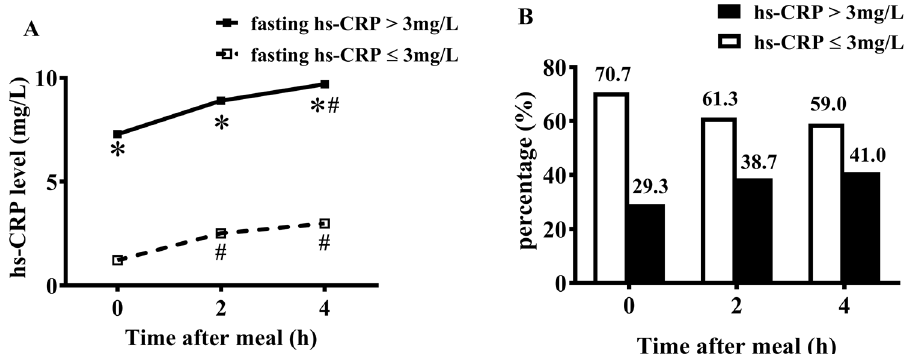
Figure 2. Comparisons of changes in hs-CRP levels after a daily meal between two groups. ( A ) Changes of postprandial hs-CRP level in two groups (i.e., CHD patients with fasting hs-CRP level ≤ 3 mg/L or not). ( B ) Comparisons of the percentages of patients with hs-CRP ≤ 3 mg/L and > 3 mg/L at different time points. *P < 0.05 when compared with fasting hs-CRP ≤ 3 mg/L group at the same time point, # P < 0.05 when compared with the fasting level within each